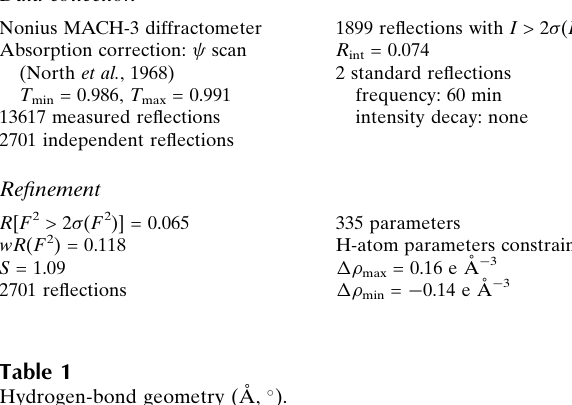
Hydrogen-bond geometry (A˚ , (cid:4)